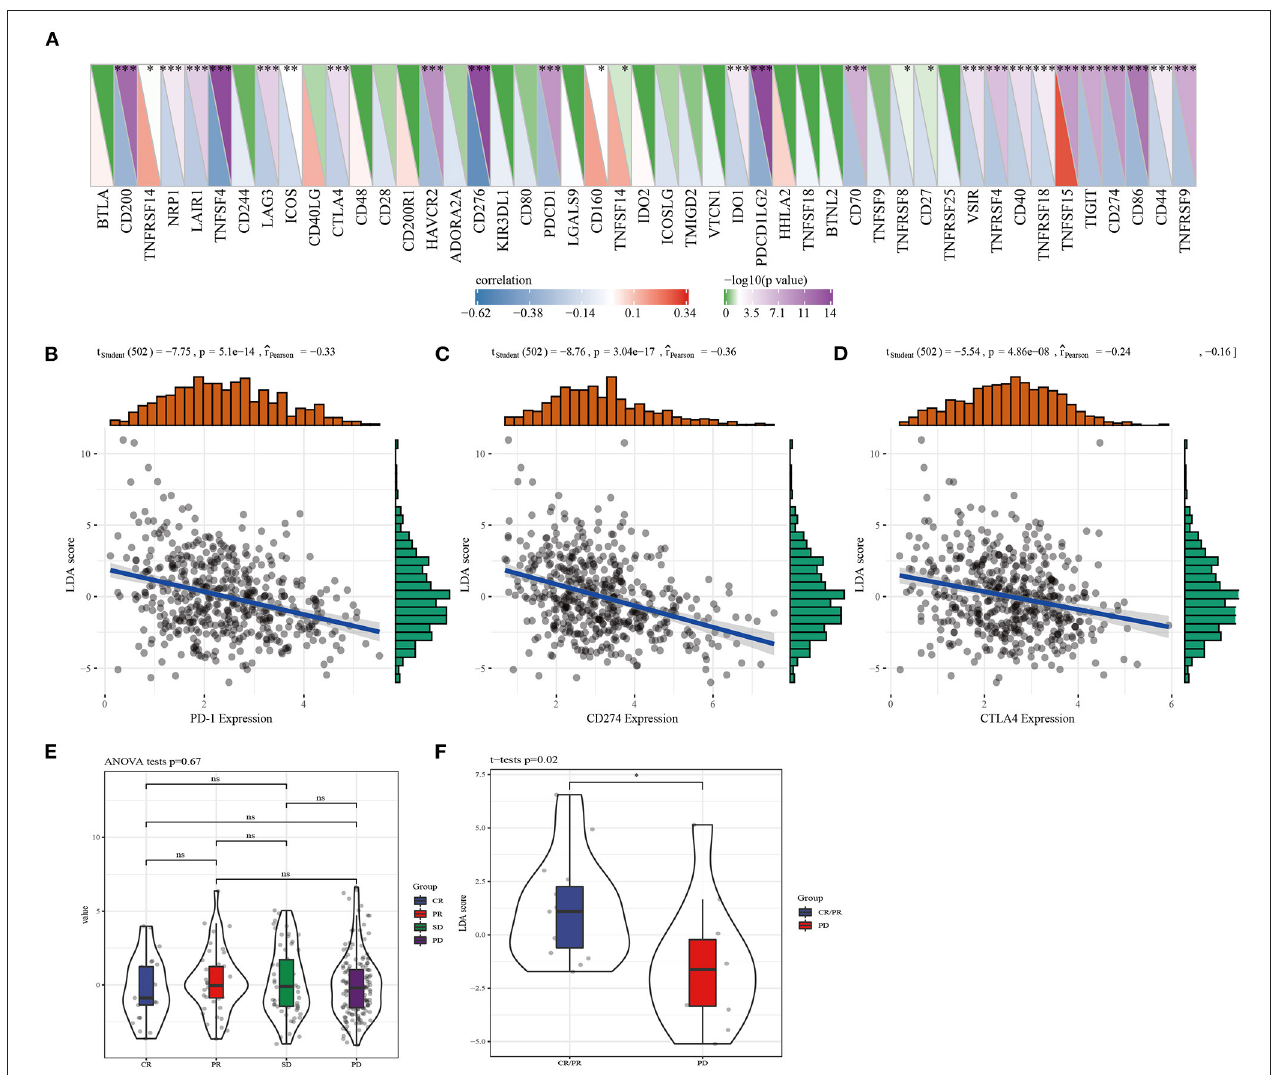
FIGURE 7 | The correlation between LDA score and LUAD immunotherapy response was assessed. (A) The immune checkpoints significantly related to LDA score were screened from 47 immune checkpoints. (B) Correlation analysis of LDA score and PD1 expression. (C) Analysis of correlation between LDA score and CD274 expression. (D) Correlation analysis of LDA score and CTLA4 expression. (E) LDA score evaluation between CR, PR, SD, and PD before anti-PDL1 treatment. (F) The difference of LDA score between CR/PR target lesions and PD target lesions was